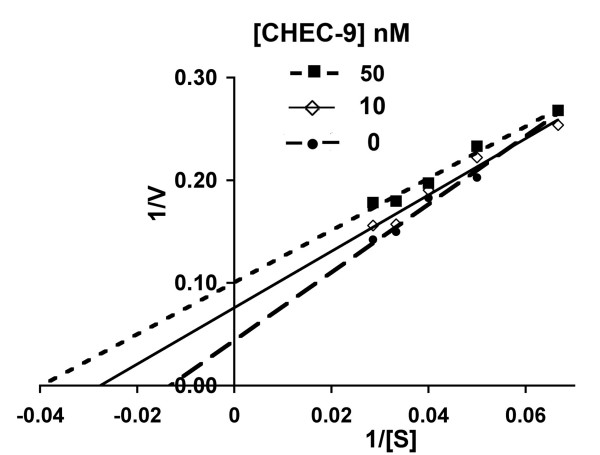
Lineweaver-Burke double reciprocal plots showing CHEC-9 inhibition of sPLA2 activity in human plasma. Plasma concentration was 20% of the reaction mixture, which also consisted of 10-pyrene at concentrations between 5–30 μM and CHEC-9 at 0, 10 and 50 nM. CHEC-9 was less effective or even exaggerated the reaction at the lower substrate concentrations causing the lines of the plot to converge with increasing values of 1/[S]. The kinetic parameters for reactions with human plasma are shown in Table 1 and are consistent with the properties of an uncompetitive inhibitor. [r2, p values for linearity of reciprocal plots: 0 nM – 0.987, 0.006; 10 nM – 0.967, 0.0026; 50 nM – 0.980, 0.0012].